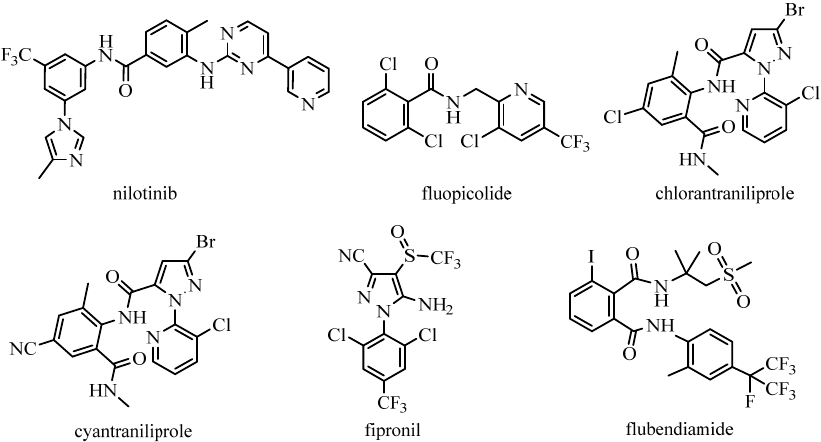
Figure 1. The chemical structures of some bioactive agents containing pyridine, amide and sulfur groups.